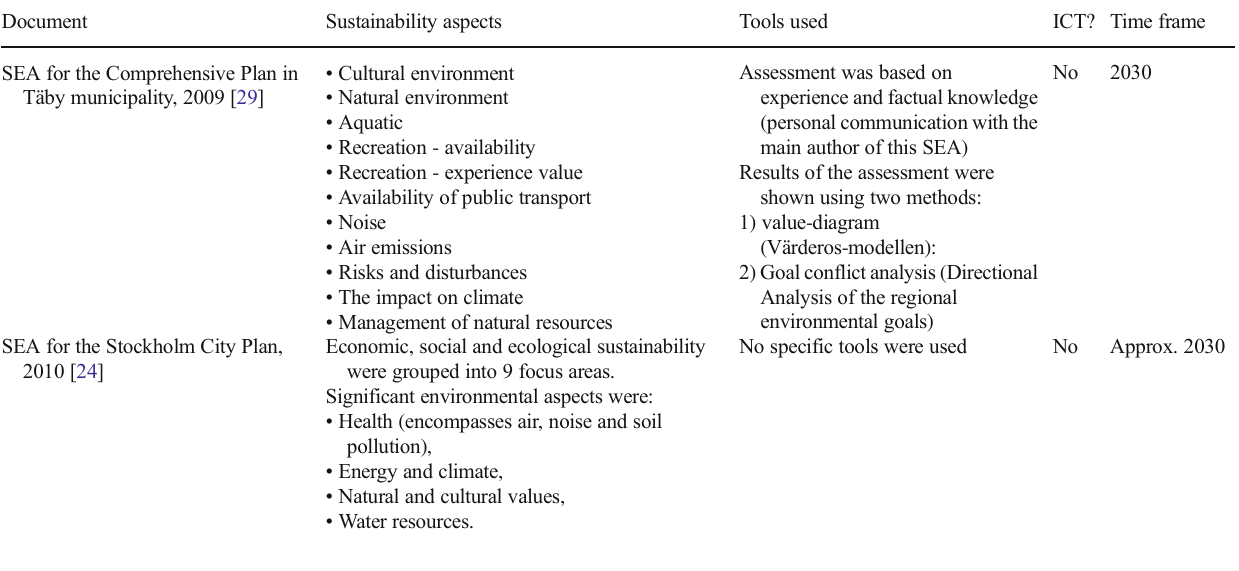
Overview of tools and aspects addressed in the reviewed SEAs Document Sustainability